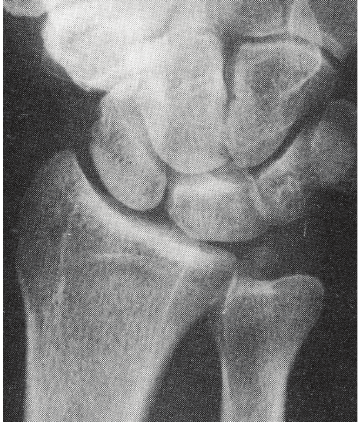
Figure 4: PA view of the right wrist demonstrating the abnormal lie of the ulnar styloid, following a hypersupination injury. (Repro- ducedbythekindpermissionoftheBritishEditorialSocietyofBone and Joint Surgery, from Graham et al.